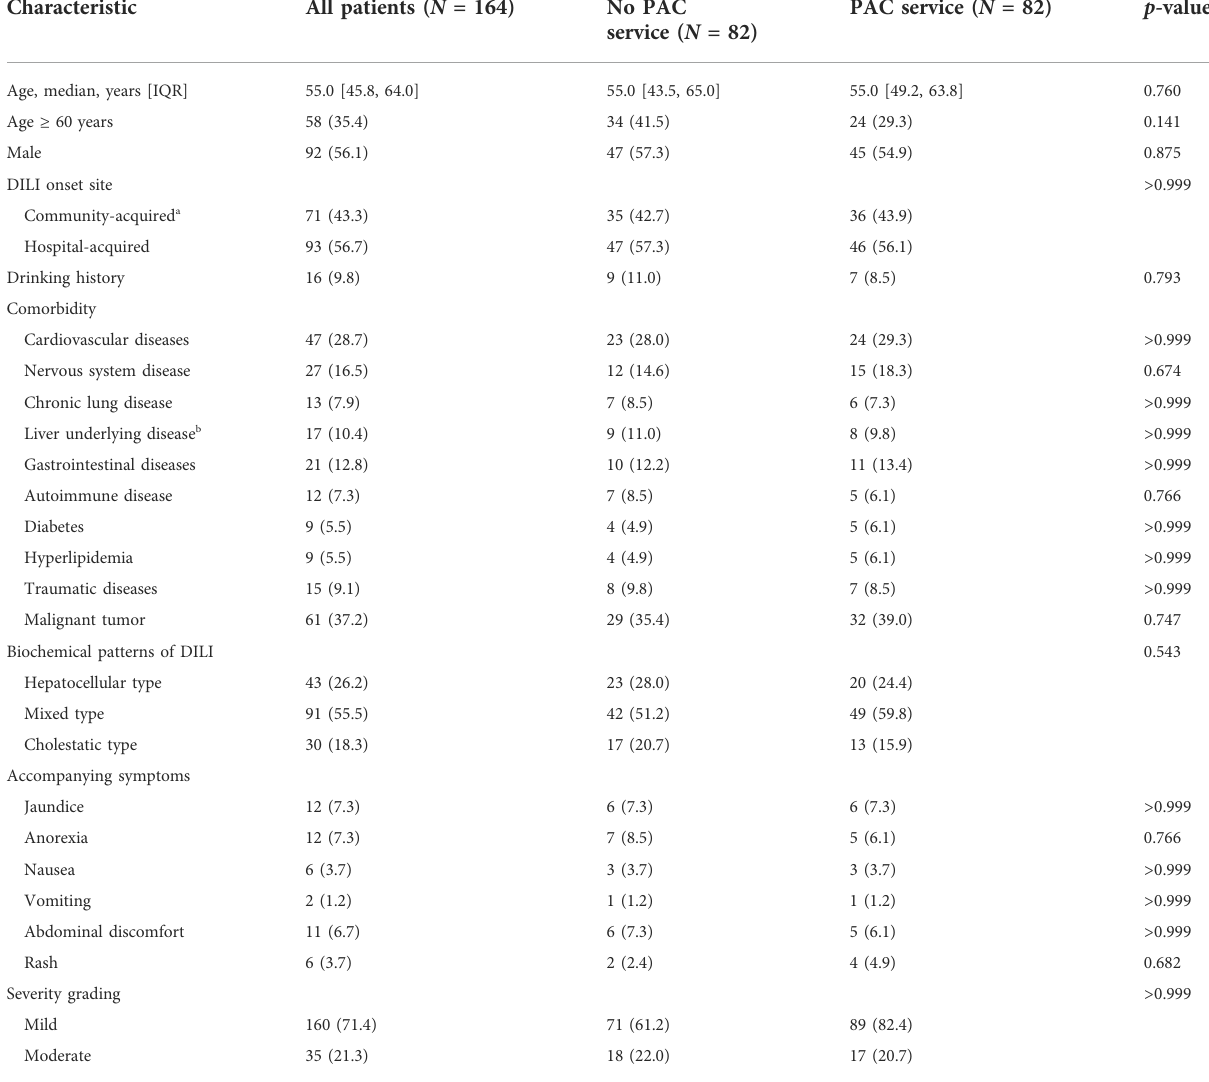
TABLE 3 Patient baseline and drug-induced liver injury characteristics in the propensity score-matched cohort.